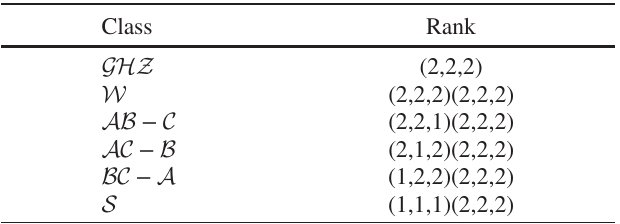
TABLE II. Three-qubit entanglement classes: The first column specifies the distinct classes, while the second one accounts for the rank of the reduced density matrices using the notation ; rank ð ρ ; rank ð ρ [rank ð ρ A Þ B Þ C Þ